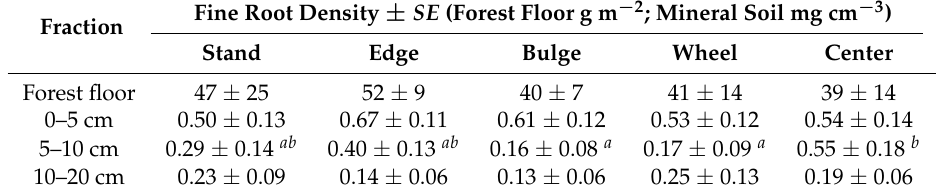
Table 3. Mean fine root density by strata including one standard error of the mean ( ± SE ). Letters indicate significant differences between strata (Dunn’s test, p < 0.05).